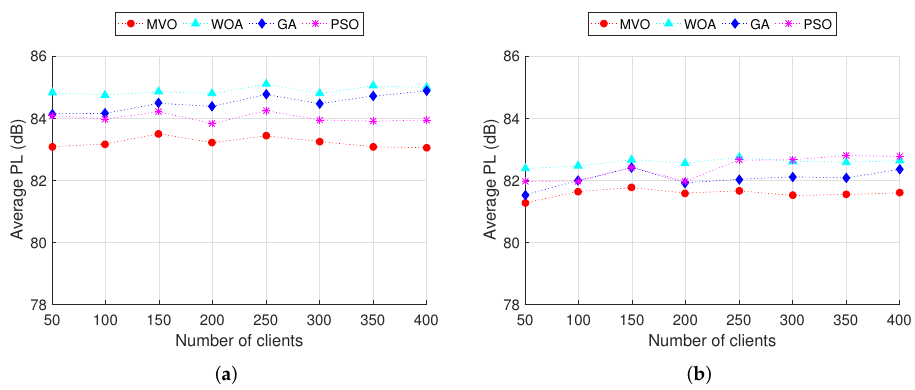
Figure 9. Performance comparison of the path loss versus the number of clients. ( a ) INS-3. ( b ) INS-4.